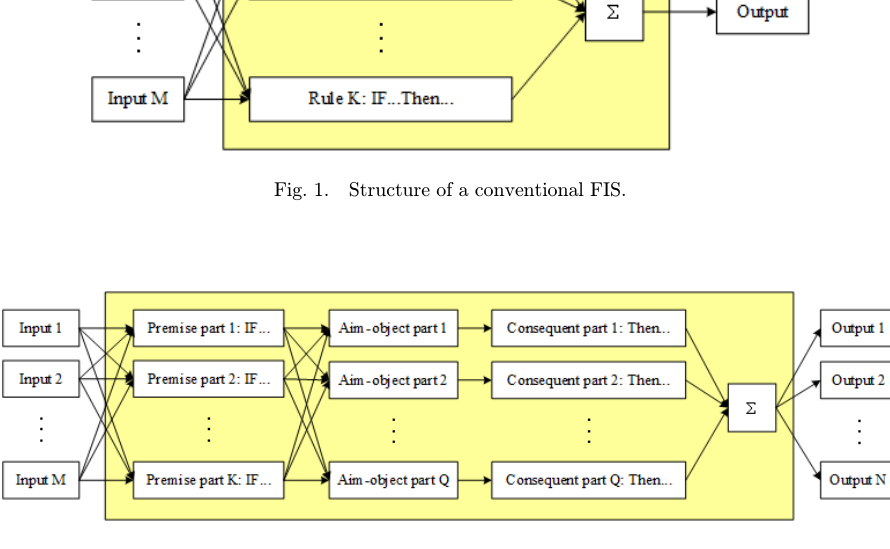
Fig. 2. Structure of the proposed